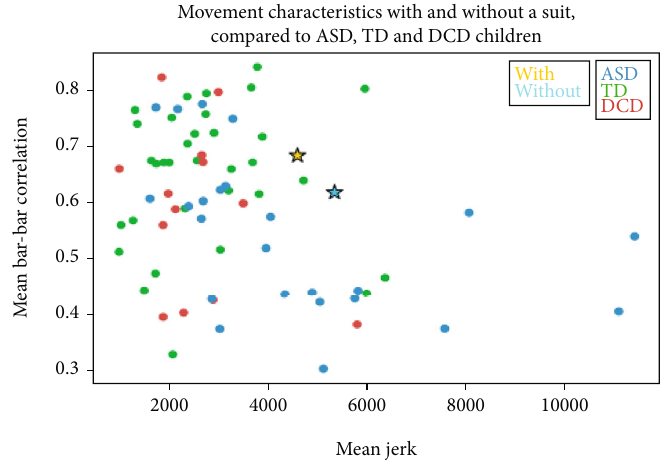
Figure 4: P ’ s position according to mean bar x bar correlation ( y ) and mean jerk ( x ) during the tightrope walker experiment compared to TD controls (green dots) and children with ASD (blue dots) or DCD (red dots). TD: typical developing; ASD: autism spectrum disorder; DCD: developmental coordination